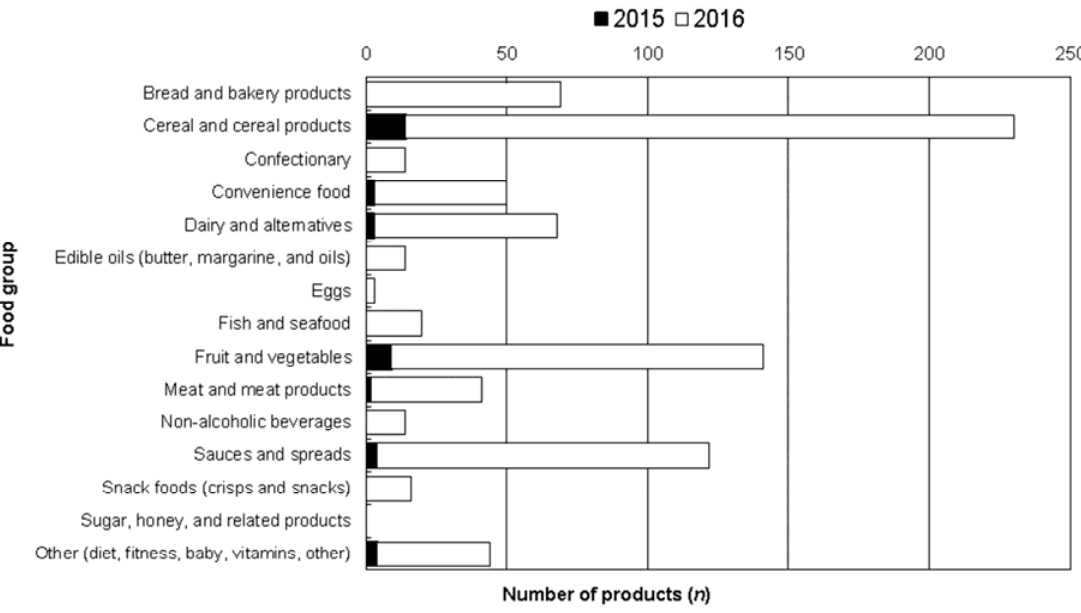
Figure 2. Number of products ( n ) displaying Health Star Rating (HSR), in 2015 and 2016. No products in the sugar, honey, and related products food group displayed a HSR label.